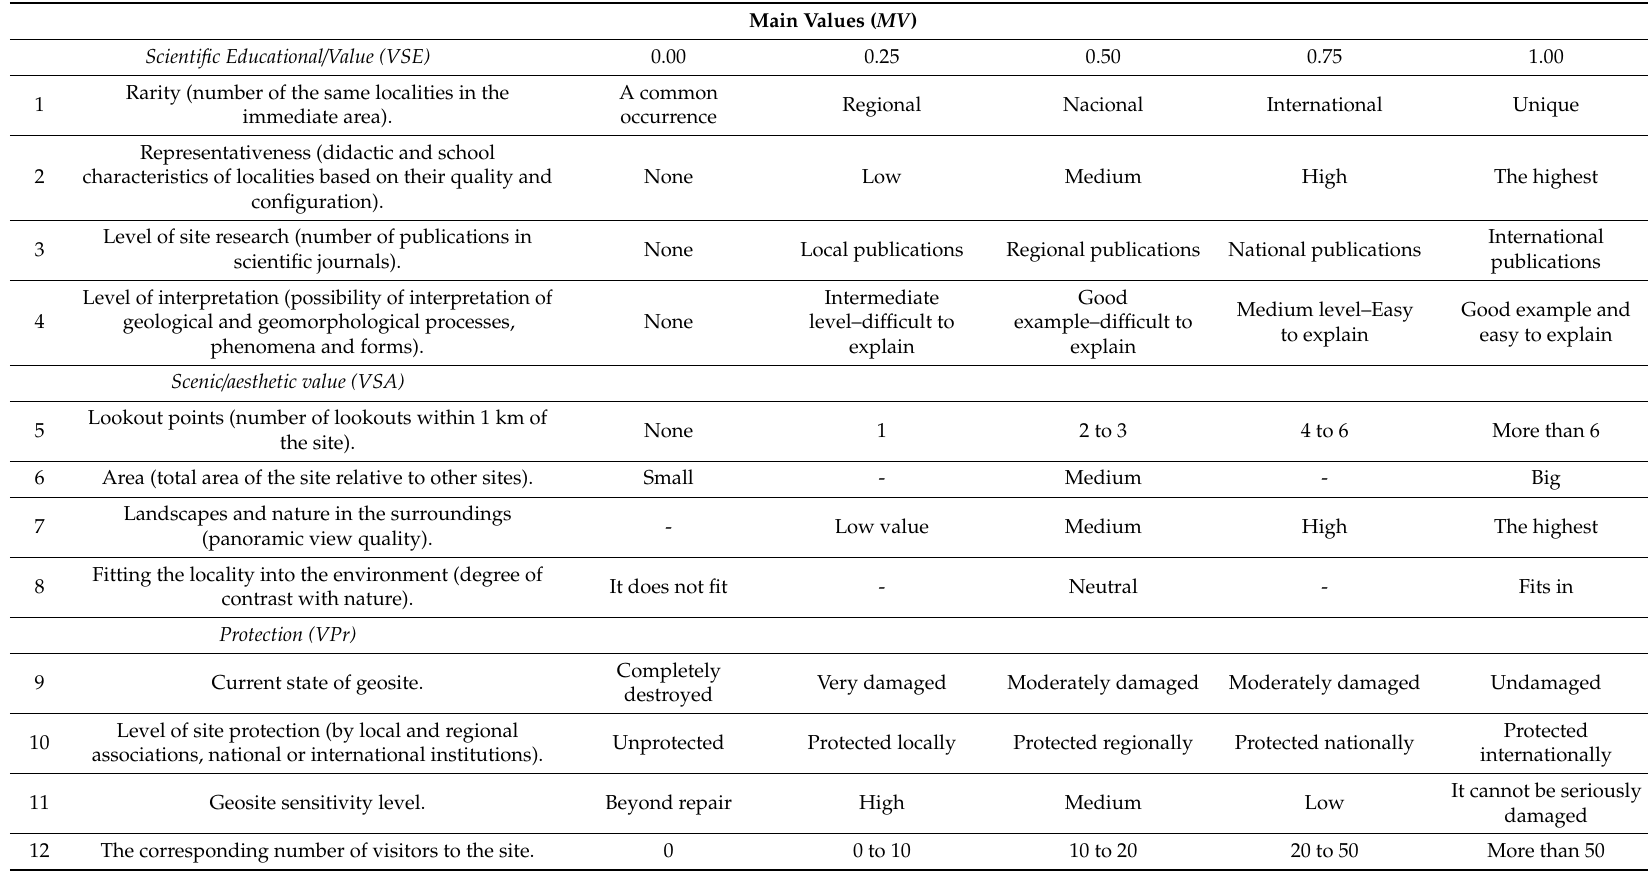
Table 1. The structure of Geosite Assessment Model